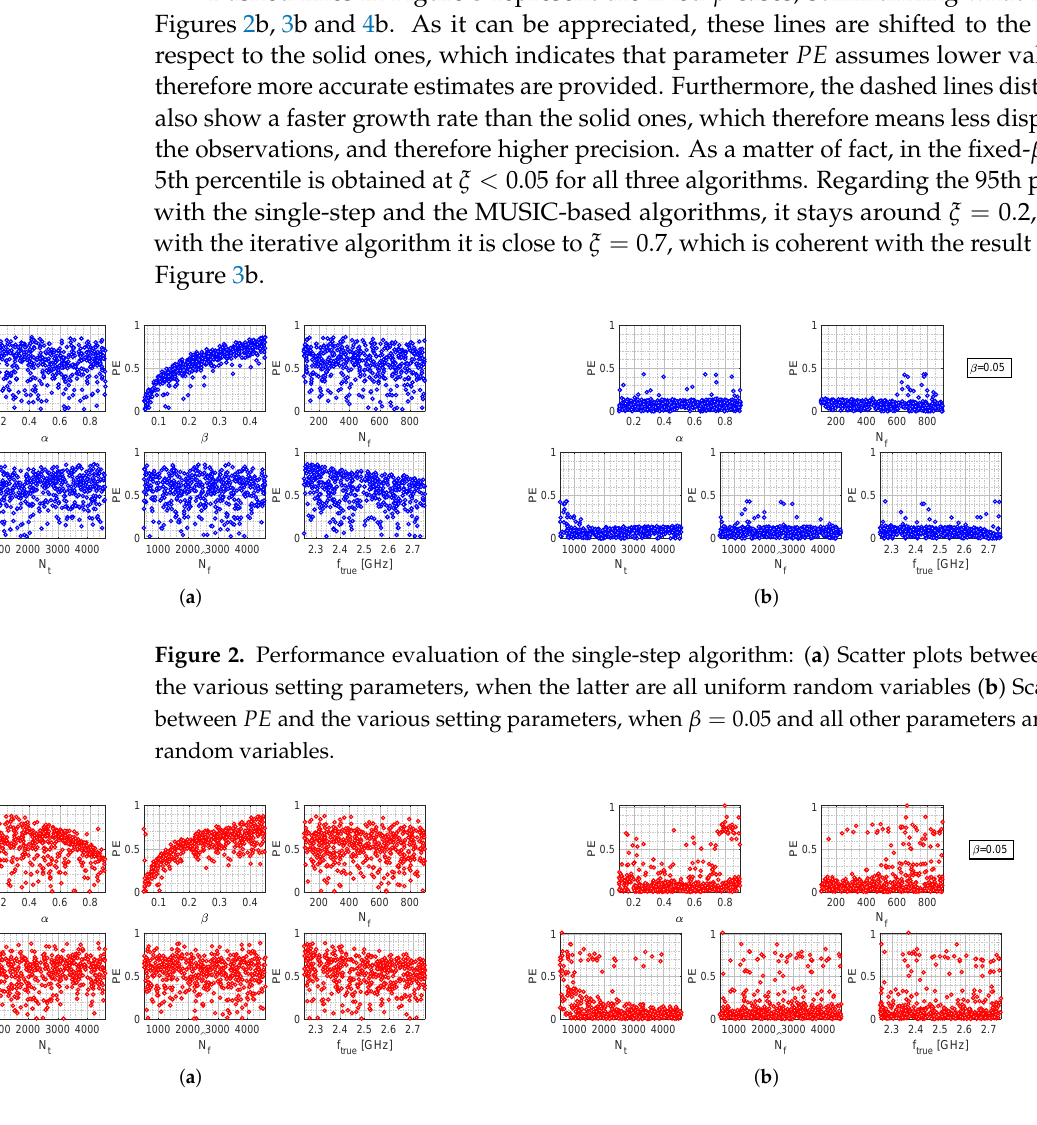
Figure 3. Performance evaluation of the iterative algorithm: ( a ) scatter plots between PE and the various setting parameters, when the latter are all uniform random variables; ( b ) scatter plots between PE and the various setting parameters, when β = 0.05 and all other parameters are uniform random